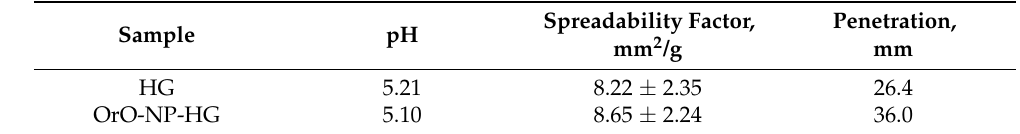
Figure 1. Light microscopy images (400×) of empty methylcellulose hydrogel ( a ) and hydrogel with oregano oil-loaded nanoparticles (Oro-NP-HG) ( b ). Table 1. Comparison of the properties of empty methylcellulose hydrogel (HG) and hydrogel with oregano oil-loaded nanoparticles (Oro-NP-HG).